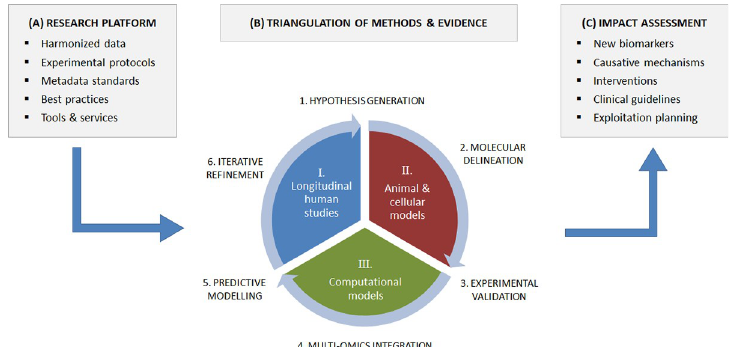
Fig 2. Overall methodology of the EarlyCause project, including (A) research platform of harmonised data from existing resources, research protocols and best practices; (B) triangulation approach, which will capitalise on the complementary strengths of epidemiological and genetic methods in humans, experimental animal and cellular models, and in silico data integration pipelines; and (C) expected results such as new biomarkers and clinical